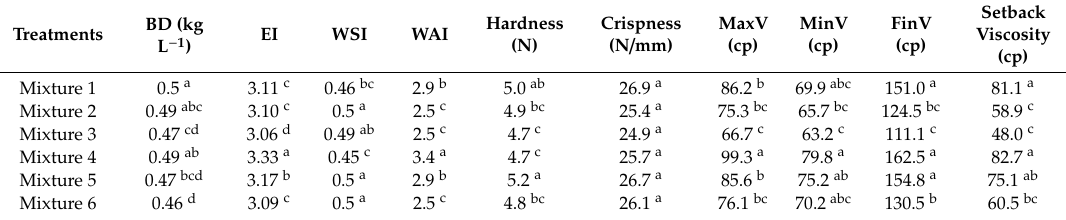
Table 4. Functional and physical properties of the extruded products